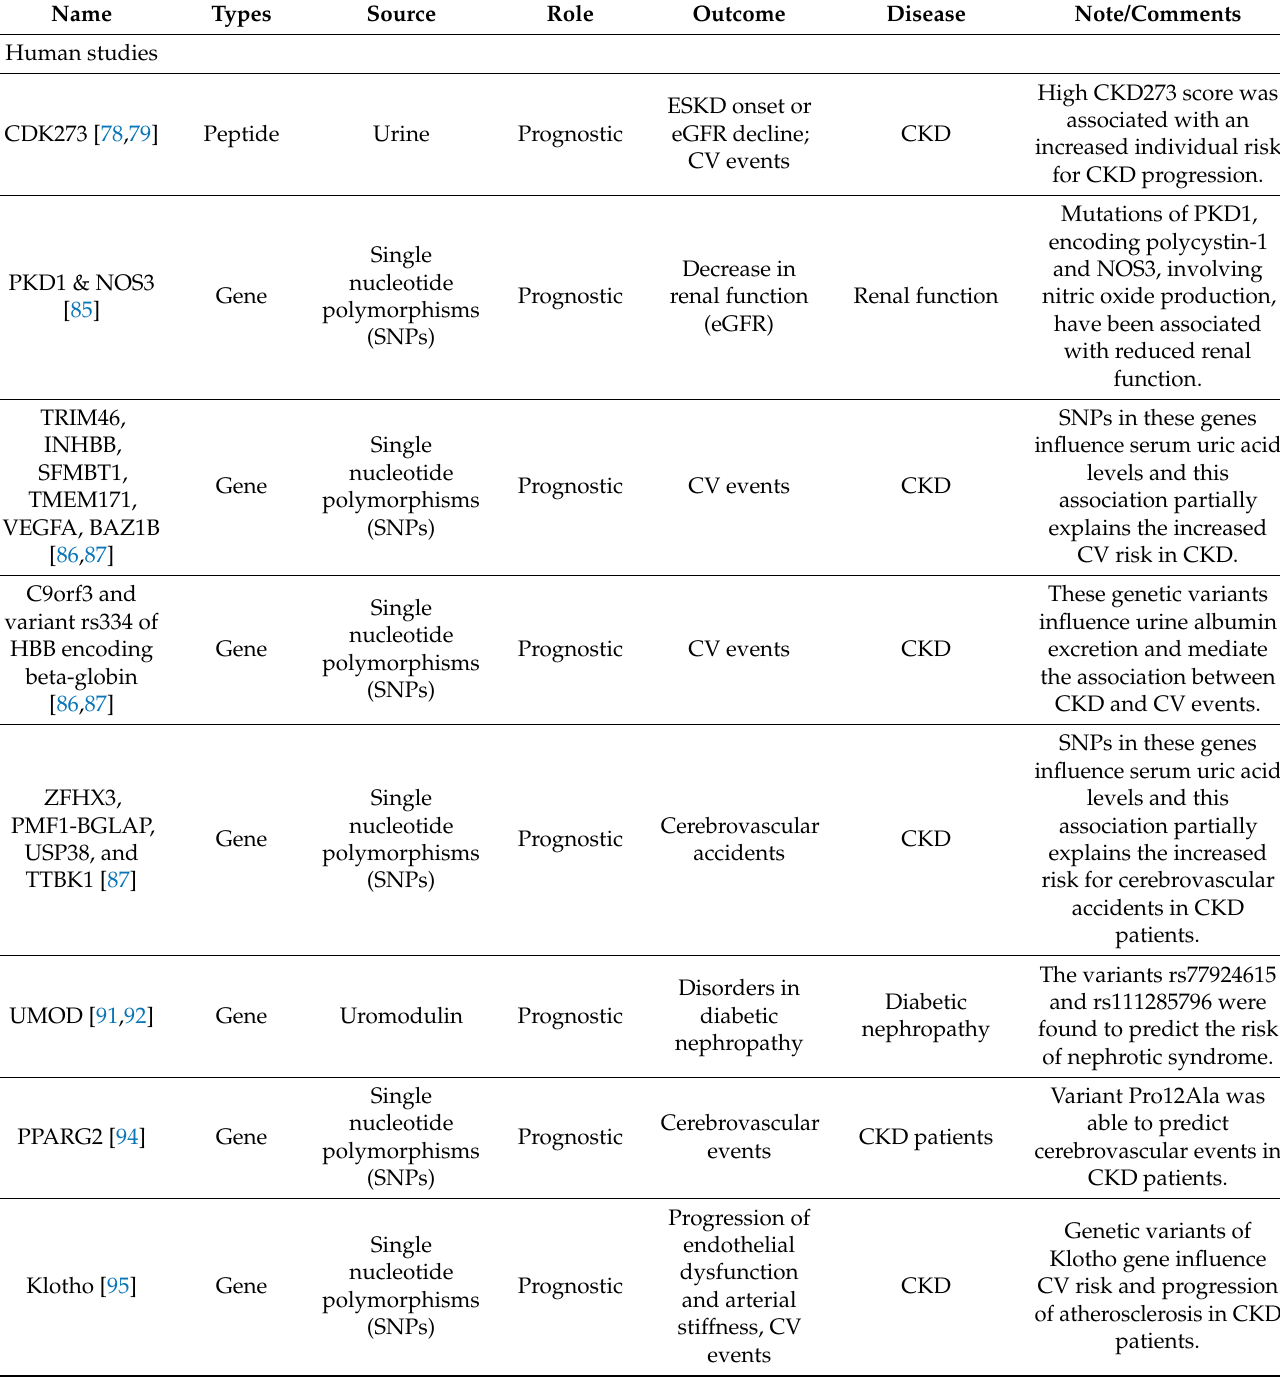
Table 1. Prognostic and predictive OMICs in chronic kidney